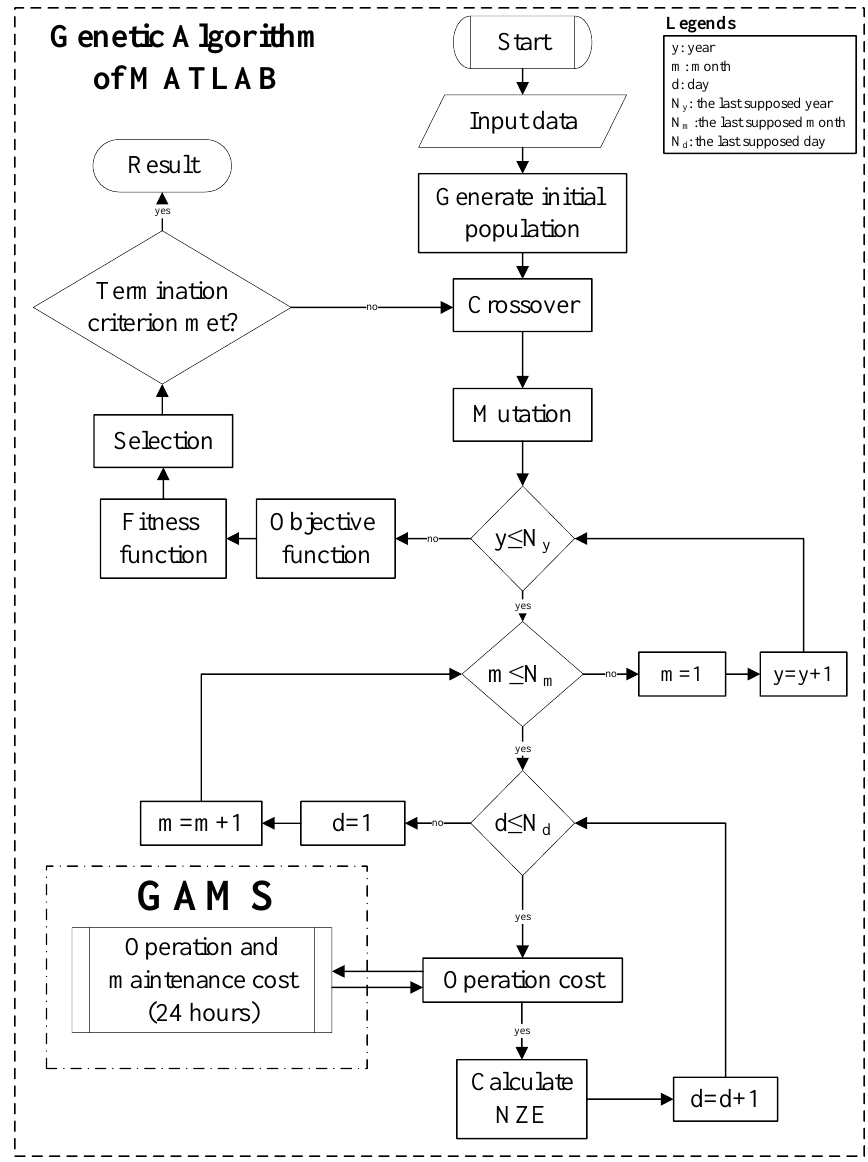
Figure 6. The flow chart of the optimization algorithm for MCMG.